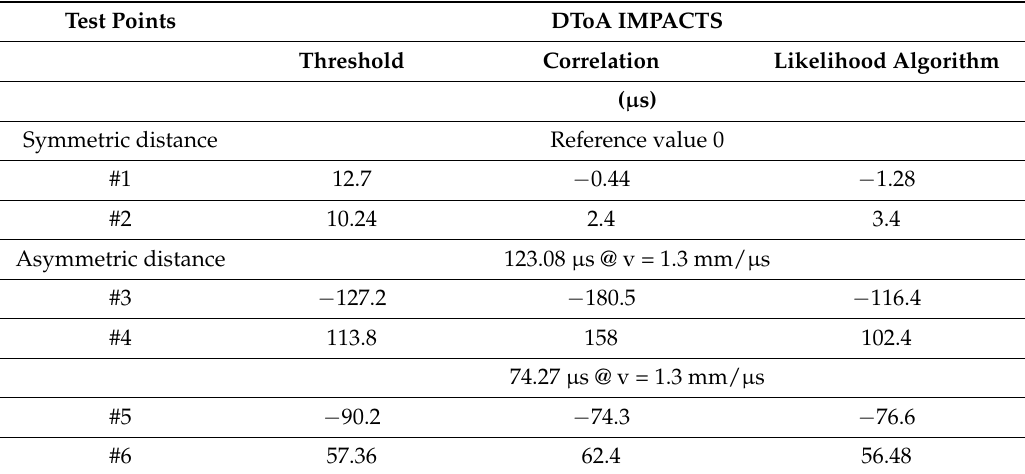
Table 1. Results of DToA obtained by the three methods.